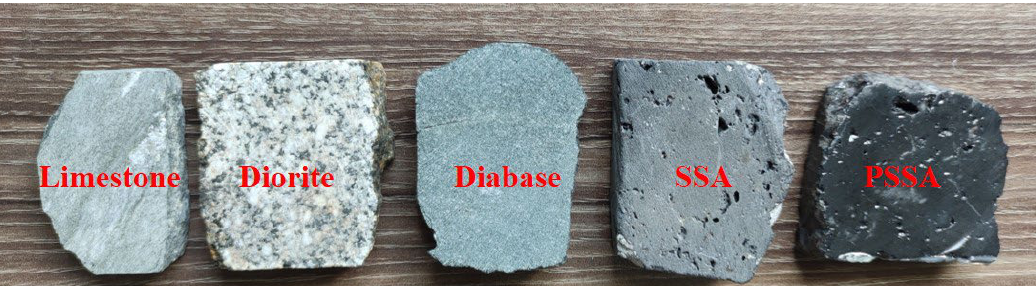
Figure 3. Aggregate samples for BBS test.